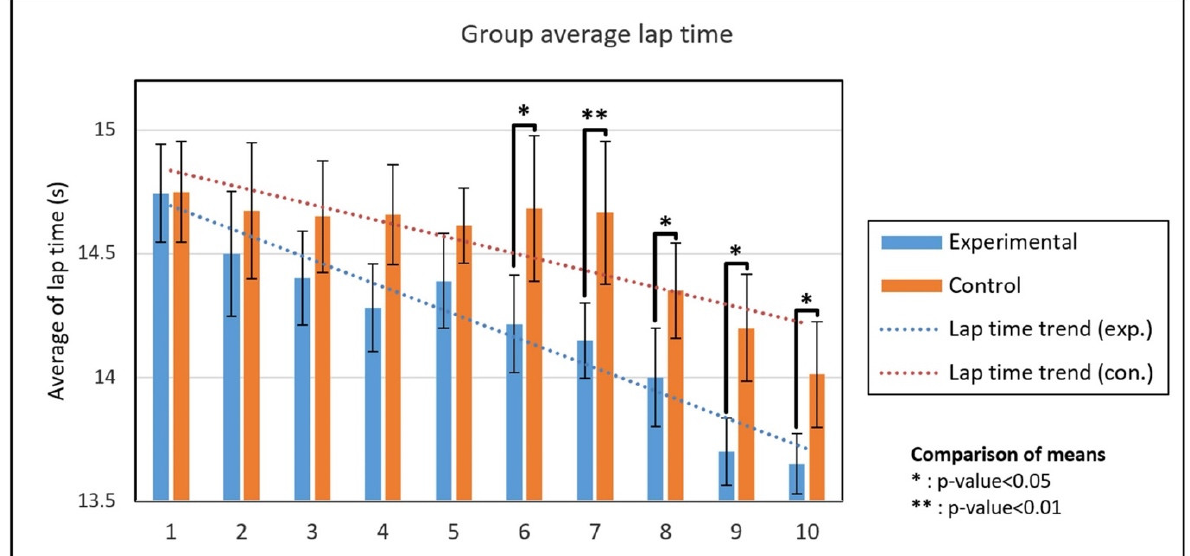
Figure 7. Average and standard deviation of lap times for the experimental and control groups during ten test sessions.